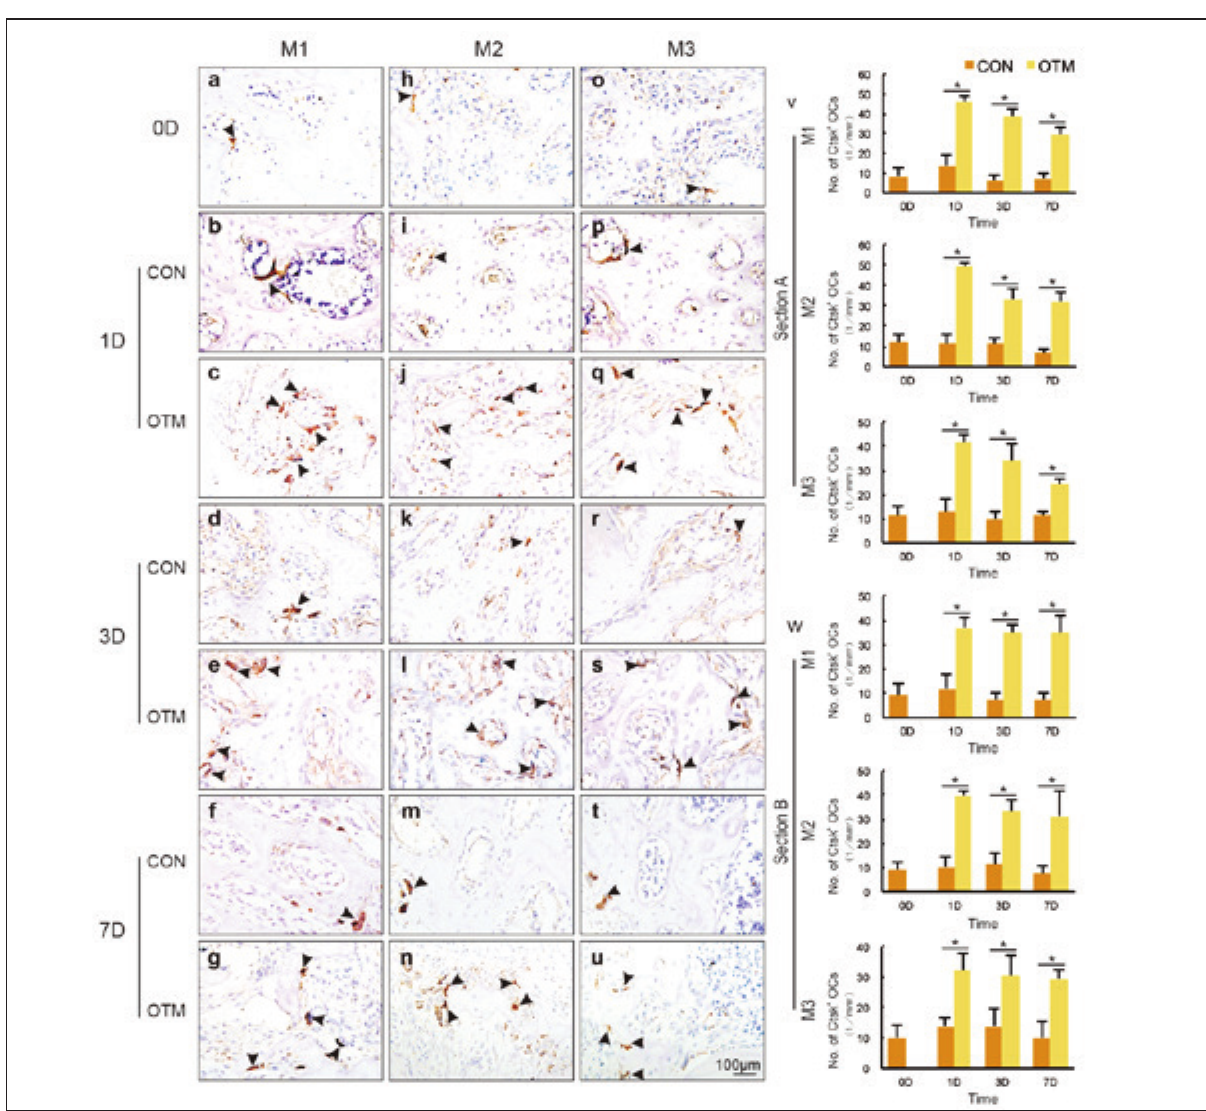
Figure 3. The local orthodontic force elevated the catabolic metabolism of the hemi-maxillary alveolar bone. CTSK IHC staining of the maxillary alveolar bone. The osteoclasts (arrowhead, CTSK-positive cells) were elevated in M1, M2 and M3 zones at both section A and B level. (* p < 0.05, N =